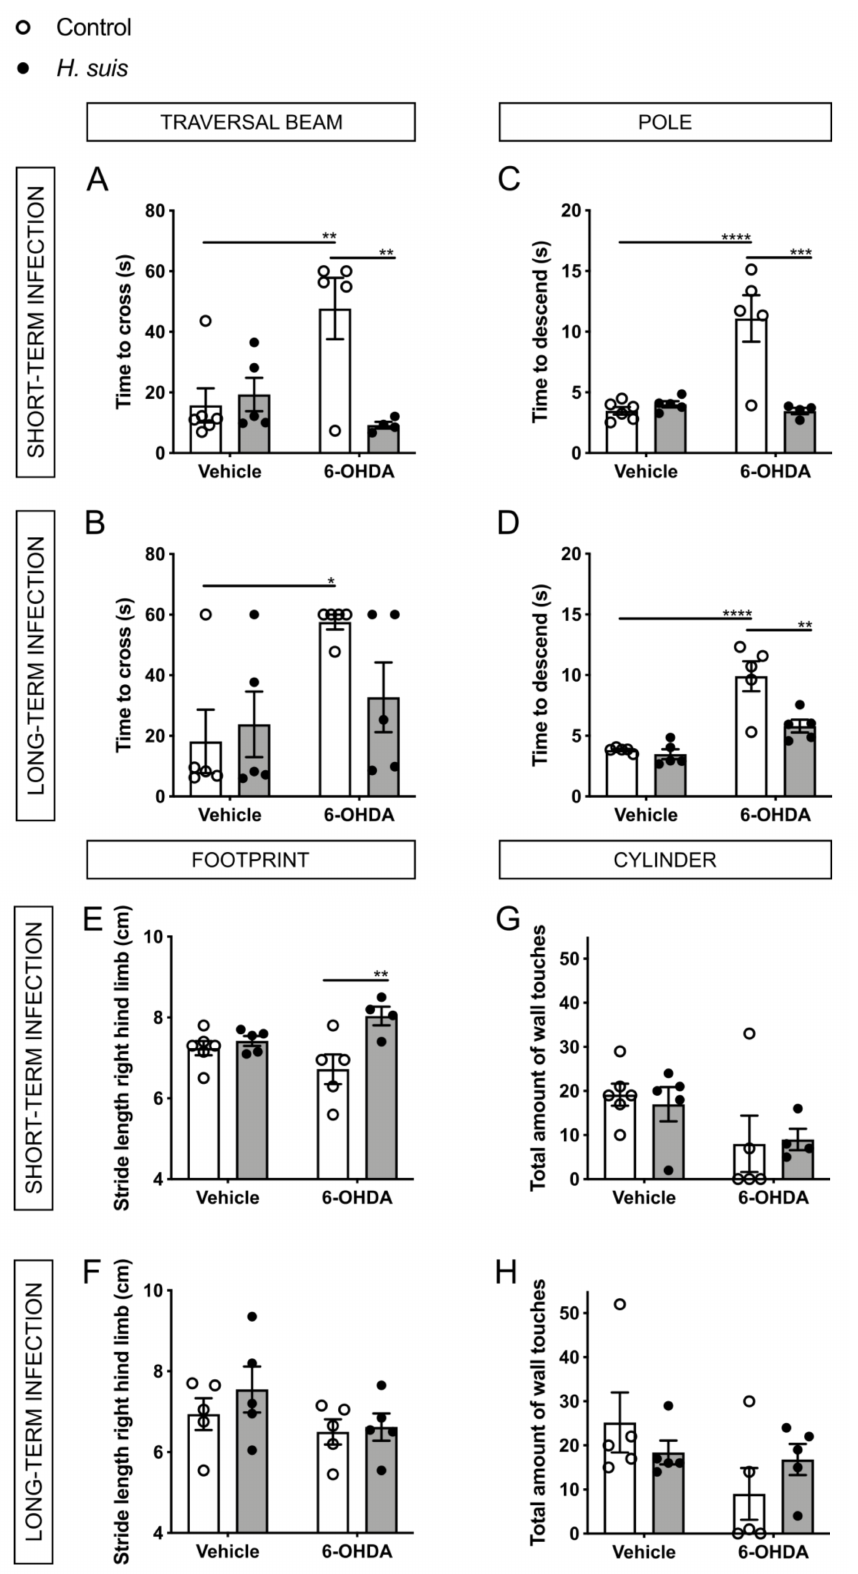
Figure 4. Helicobacter suis ( H. suis ) - infected mice are partially protected against the motor deficits induced by intrastriatal 6-hydroxydopamine (6-OHDA) injection. ( A , B ) Time (in seconds (s)) to cross the traversal beam, 7 days after intrastriatal injection with either 6-OHDA (n = 4–5) or vehicle (n = 5–6), of mice infected with H. suis (black) or the control broth (white) for a short-term ( A )